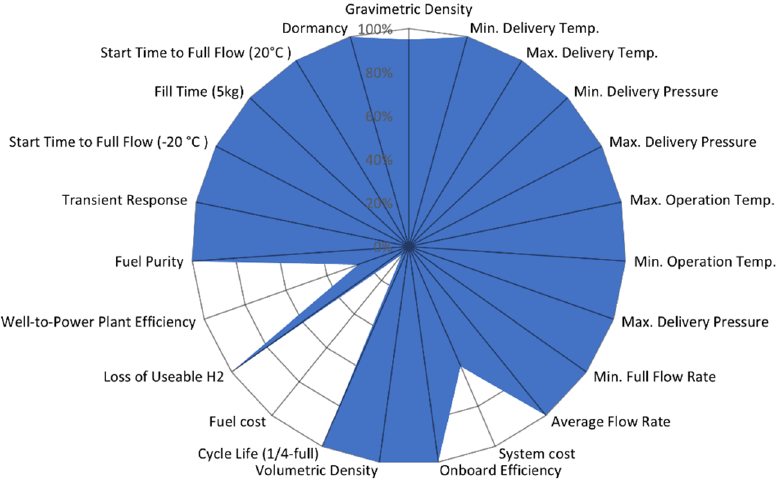
Figure 11. Projected ammonia borane system compared against 2020 Targets, 50% mass loaded slurry, from DOE [105].